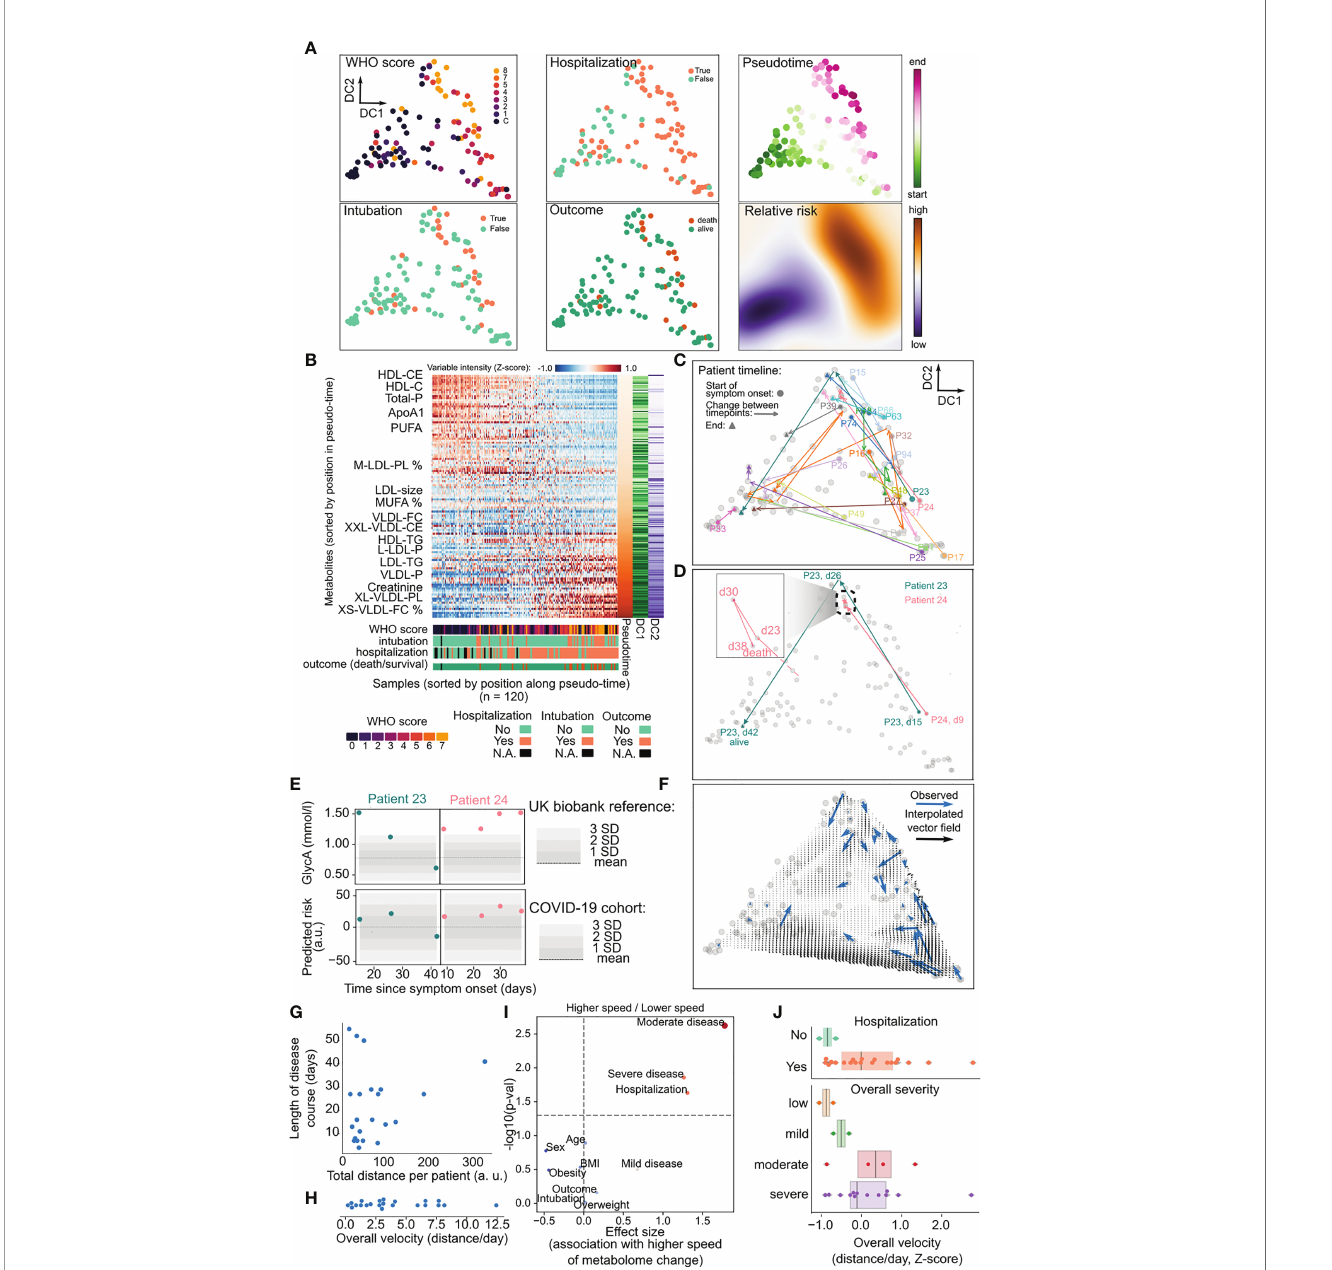
FIGURE 3 | Use of metabolic data for precise disease monitoring. (A) Latent representation of metabolic data for all samples in two dimensions using diffusion maps, from which diffusion components (DC) are derived. In the fi rst two panel columns samples are colored by their value of WHO score, whether the patient was hospitalized, intubated and their survival. The rightmost column indicates the position of each sample within the inferred pseudotime and the relative risk for the whole two-dimensional space. (B) Heatmap with relative abundance of metabolites for all the samples where both axes are sorted by their relative position along the inferred pseudotime. The lower part of the plot indicates the values of clinical parameters for every sample. (C) Trajectory of each patient across the latent space during their clinical course starting with the day of symptom onset. Patients with at least three samples are colored distinctly while the remaining are colored in gray. (D) Particular trajectories for patients 23 and 24 as in c). The inset illustrates the stagnated course of patient 24. dN = n days since symptoms onset. (E) Values of GlycA and the predicted risk for patients 23 and 24 along the clinical trajectories of each patient. The shaded area in the GlycA plots represents the distribution of that metabolite in the UK biobank cohort, while the shaded area for predicted risk represents the distribution of the COVID-19 cohort. (F) Vector fi eld of velocities in the latent space interpolated from the observed velocity vectors for all patients (blue). (G) Relationship between total distance moved per patient in the latent space over the whole clinical course and its length in days from symptom onset. (H) Distribution of average velocities across the whole clinical timeline for every patient. (I) Association analysis between clinical variables and the average velocity of each patient. p -values have been adjusted with the Benjamini-Hochberg FDR method. (J) Illustration of differences between patient velocities and their hospitalization or overall disease severity across the whole clinical